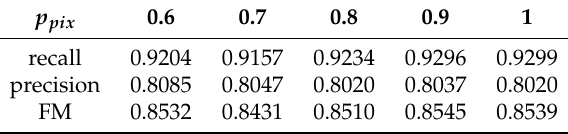
Table 4. Average evaluation metrics of different p pix